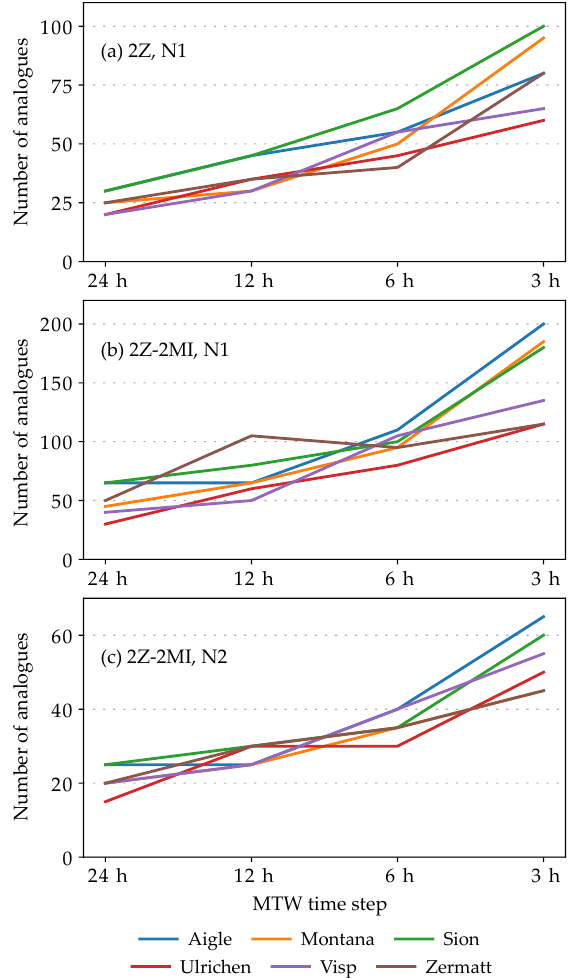
Figure 13. Optimal number of analogues of the first and second levels of analogy, N 1 and N 2 , respectively, for the (a) 2Z and (b, c) 2Z-2MI methods after recalibration using the